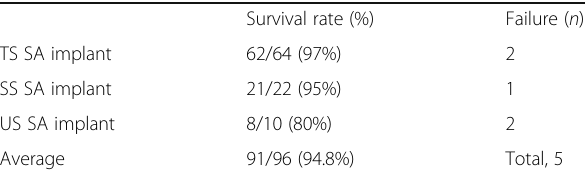
Table 4 Survival rates of implants